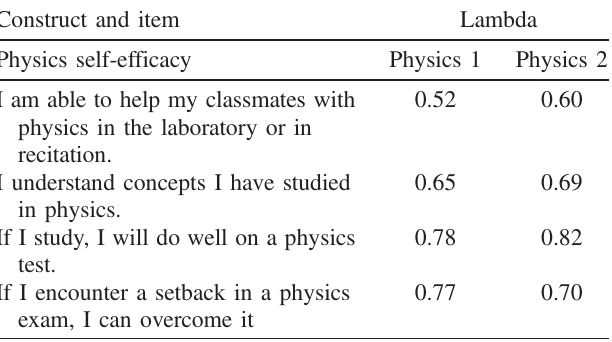
TABLE I. Survey questions for each of the